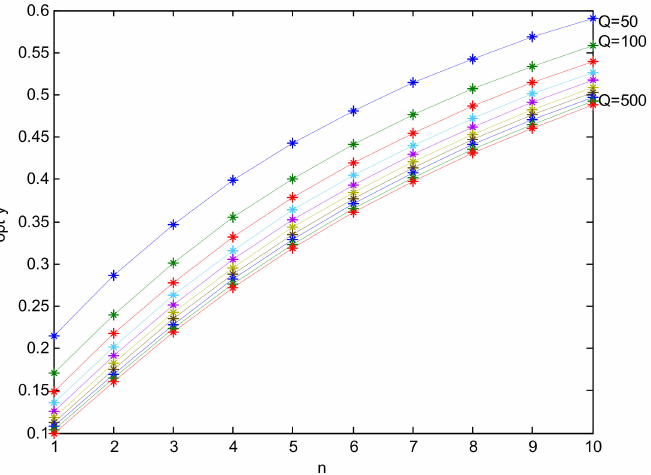
Figure 8. The optimal y under different n